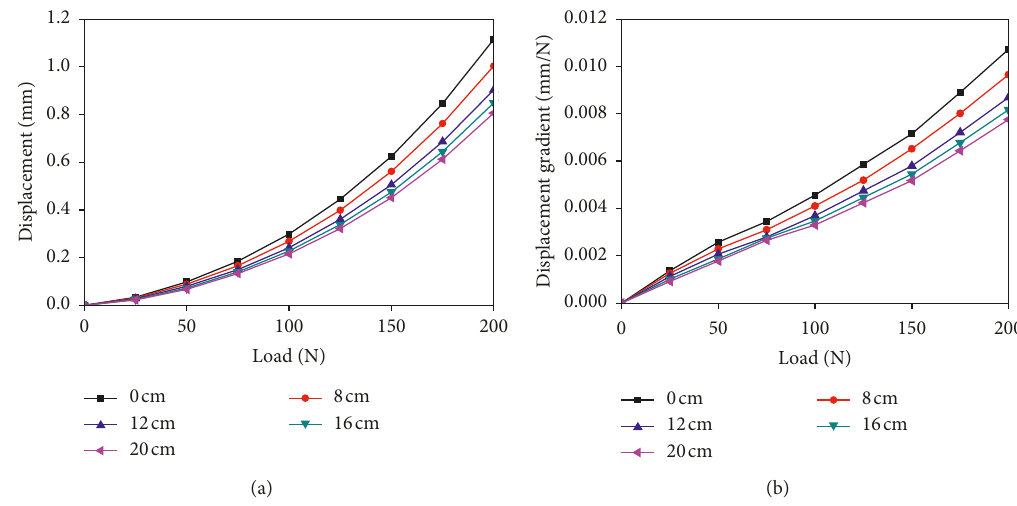
Figure 12: Load-displacement curves and load-displacement gradient curves of the CCFSTP under various L